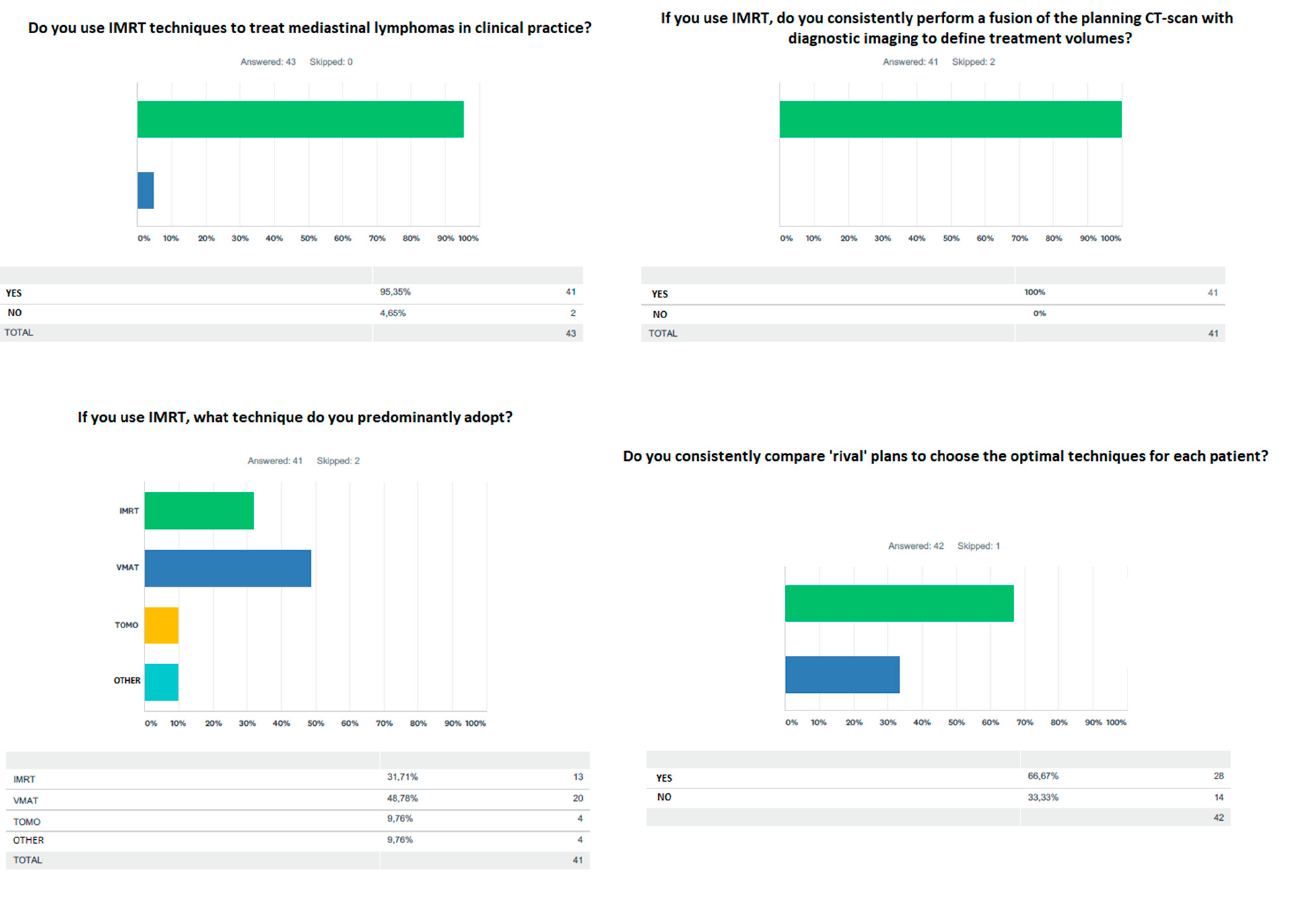
Figure 1. Adoption of intensity-modulated radiotherapy (IMRT), fusion with diagnostic imaging and preferential technique used (VMAT = volumetric modulated arc therapy; Tomo = tomotherapy) across different centers.